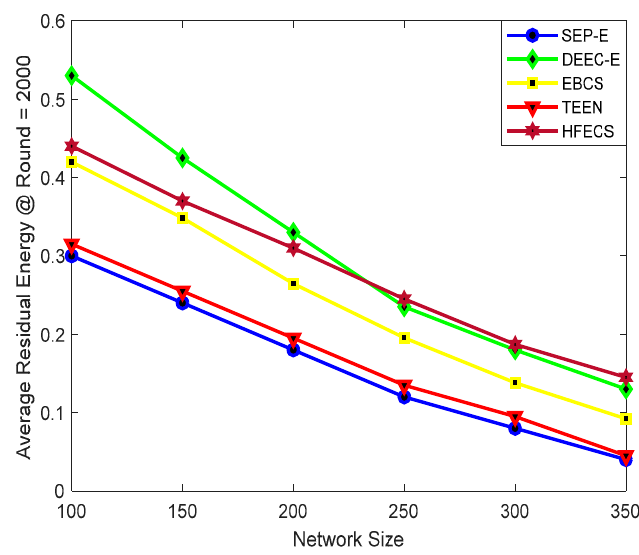
Figure 6. Average residual energy at round=2000 against variable network size.